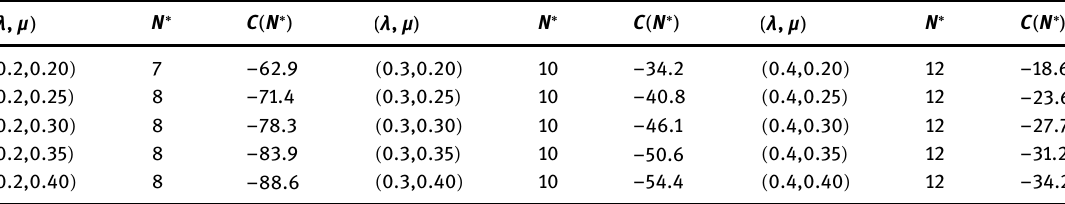
Table 3: The expected